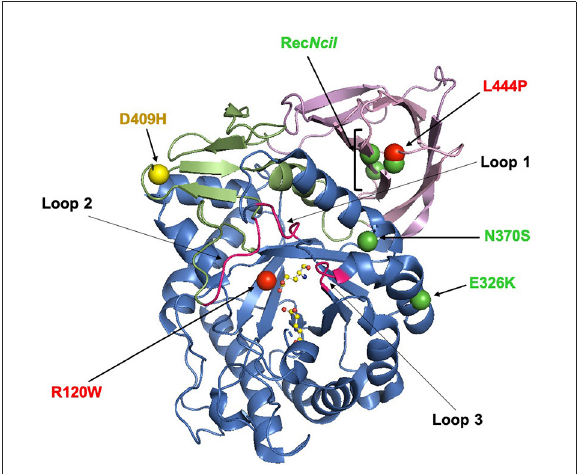
FIGURE1 The X-ray structure of glucocerebrosidase (PDB code 3GXI). Domain I is shown in orange. Domain II is shown in pink. Domain III, the catalytic domain, is shown in blue and contains the active-site residues E253 and E340 which are shown as ball-and-stick models. The six significant glucocerebrosidase variants (R120W, L444P, E326K, N370S, D409H, and Rec Ncil ) are shown with spheres. The color of the spheres corresponds with the odds ratio associated with the variant: green ( < 5); yellow (5–10) and red ( > 9) (13, 14). This figure was created using The PyMOL Molecular Graphics System, Version 2.0 Schrödinger,